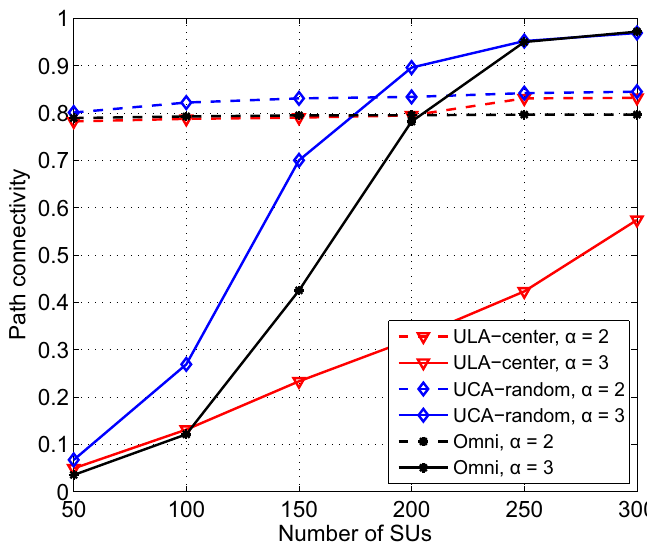
Figure 10. Path connectivity corresponding to different kinds of antennas and beamforming schemes as a function of the number of SUs with path loss exponent α = 2 and 3, a = 500, M = 6, N S = 200, N P = 3, λ P = 0.1, γ th = 50